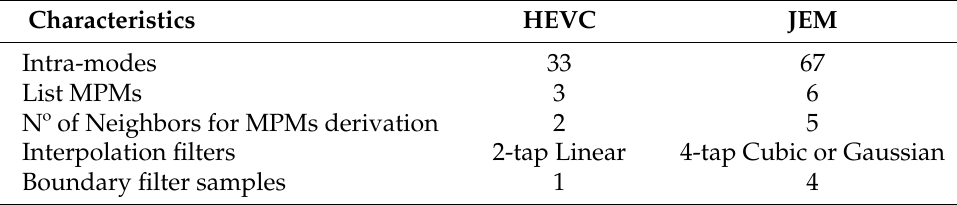
Table 2. Differences between HEVC and JEM with respect to the spatial